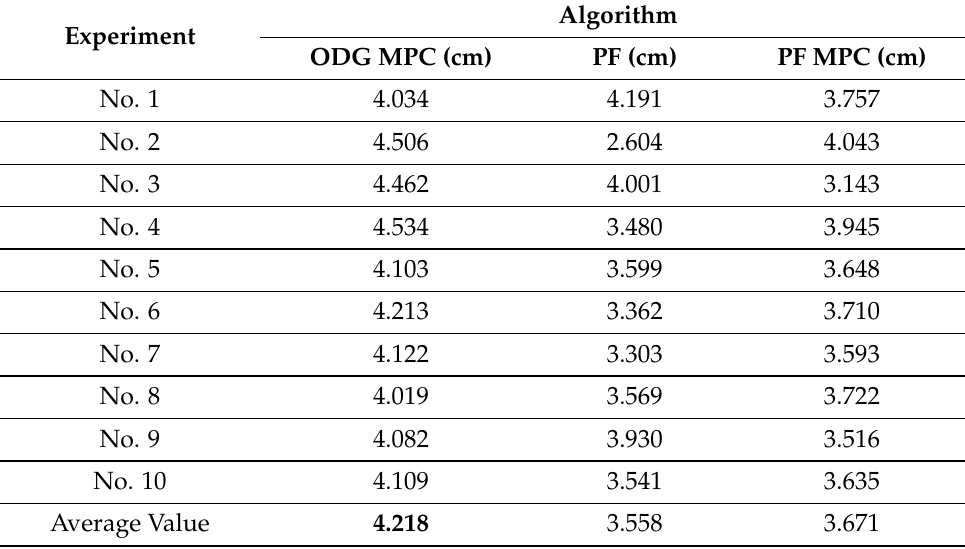
Table 7. Results for the minimum distance from Scenario 2 for a static obstacle.